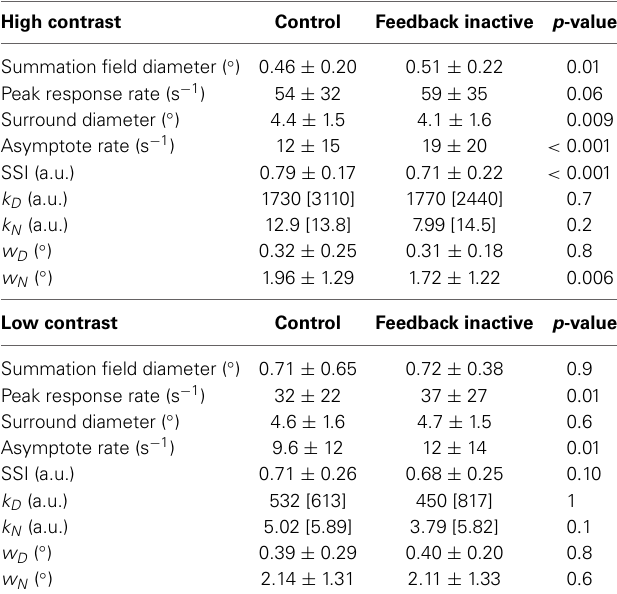
Table 1 | Feedback’s effect on area summation curve features and model parameters.